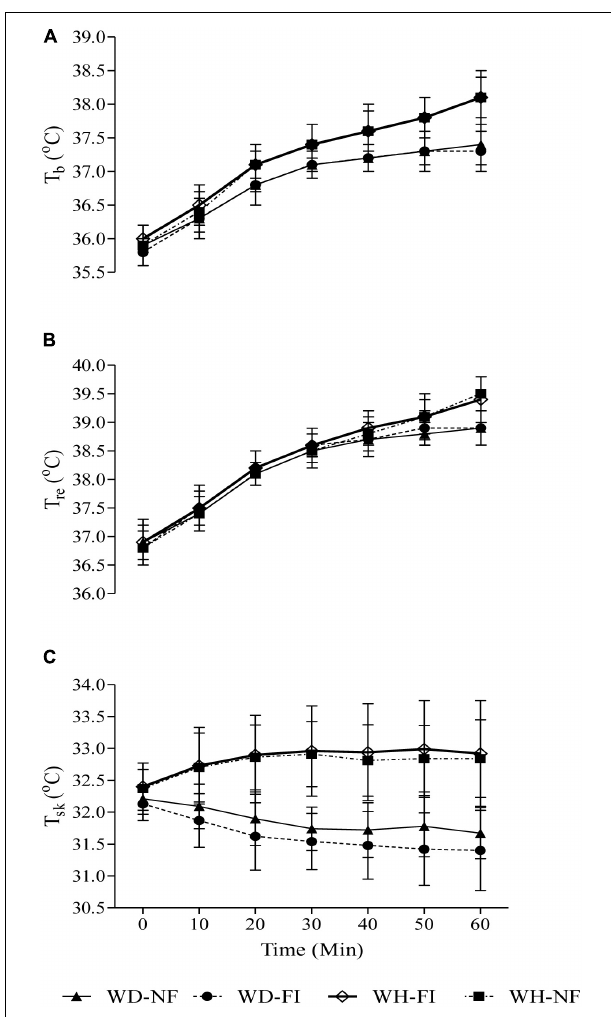
FIGURE 1 | Mean body temperature (A) , rectal temperature (B) , and weighted mean skin temperature (C) responses during the steady state exercise in the fluid ingestion (FI) and non-fluid ingestion trial (NF) in a warm-dry (WD) and warm-humid (WH) condition.